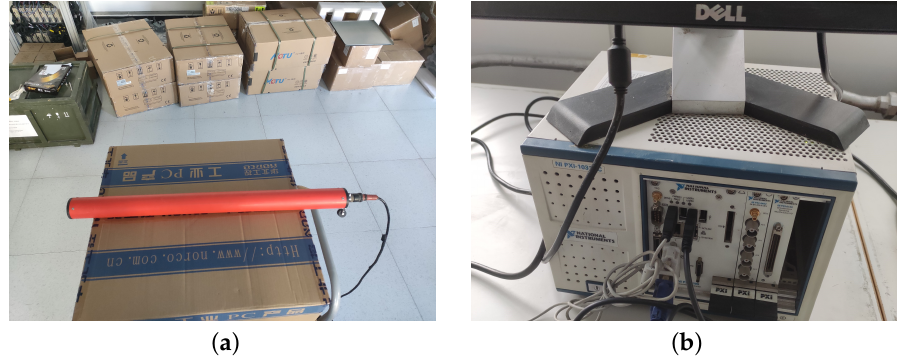
Figure 8. ULF receiver: ( a ) magnetic sensor; ( b ) NI sampler.